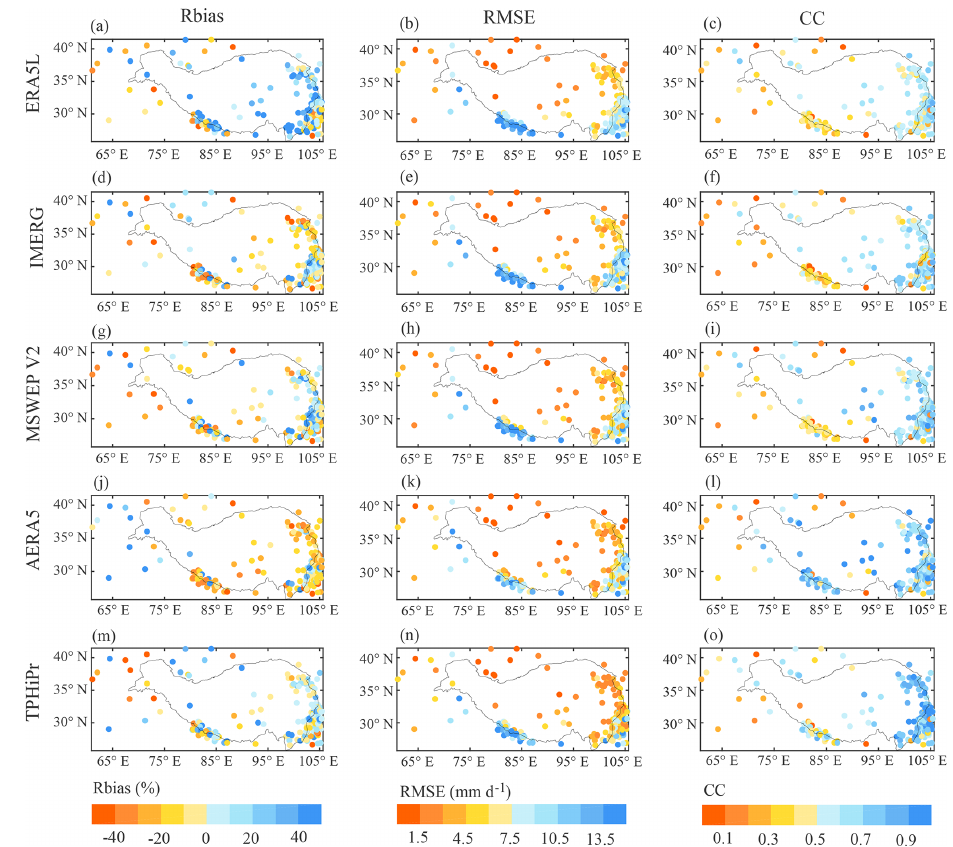
Figure 10. Spatial distribution of Rbias (first column), RMSE (second column) and CC (third column) for (a–c) ERA5L, (d–f) IMERG, (g–i) MSWEP v2, (j–l) AERA5 and (m–o) TPHiPr. The metrics are calculated at a daily scale.